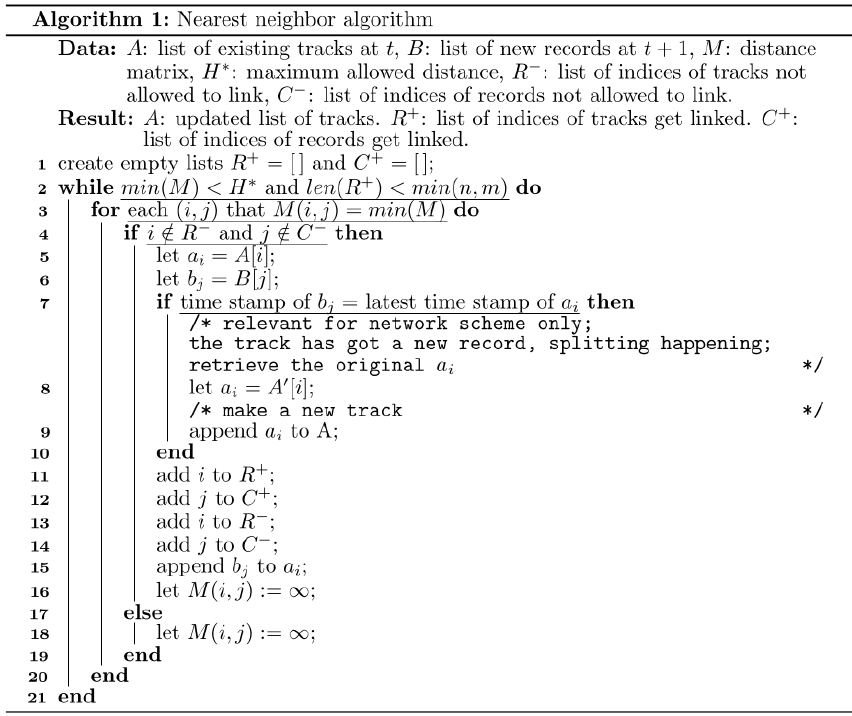
Figure A2. Nearest neighbor